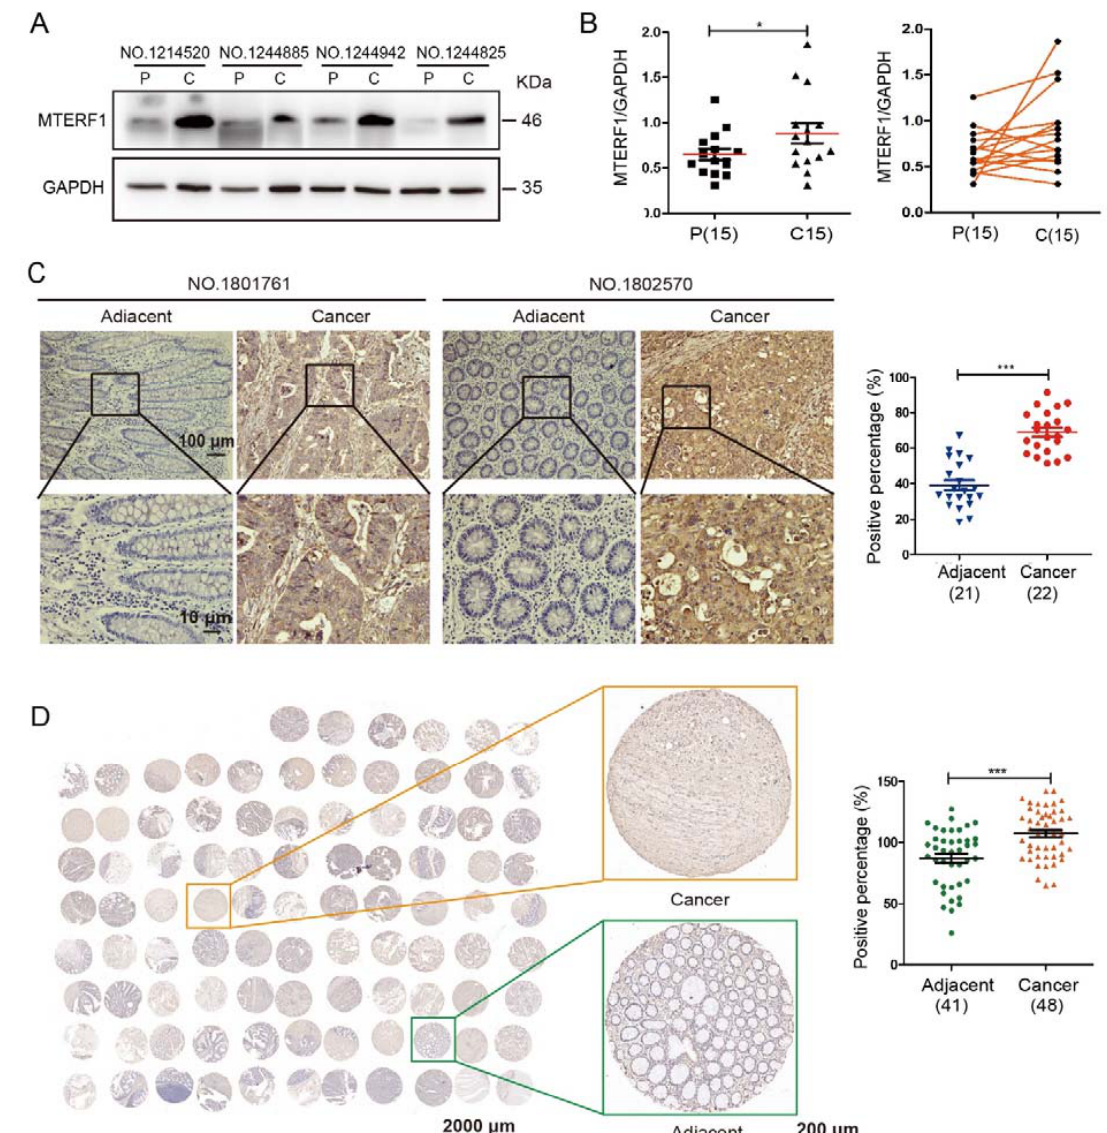
Figure 1. Expression analysis of MTERF1 protein in clinical tissues of CRC. ( A , B ) Western blotting analysis ( A ) and quantification ( B ) of MTERF1 expression in CRC tissues and paired adjacent normal tissues. P, paired adjacent normal tissues; C, CRC tissues. The diagonal line ( B ) connects the CRC tissues with paired adjacent normal tissues. GAPDH was used as an internal control. ( C ) Representative image of IHC staining of the expression of MTERF1 protein in clinical tumor tissues from CRC patients and corresponding adjacent tissues. Quantification of IHC is shown on the right. Scale bar: 100 µ m. ( D ) Colorectal cancer TMAs that contain colon cancer tissues and paired adjacent normal tissues were stained with MTERF1 antibodies, and the quantification data for IHC are shown. Representative images with differential magnification of immunohistochemistry (IHC) staining are shown. Orange and green squares indicate higher magnification views of left regions boxed. Scale bar: 2000 µ m. * p <0.05, *** p <0.001 by two-tailed Student’s t -test. Data represent the mean ± SD from three independent biological